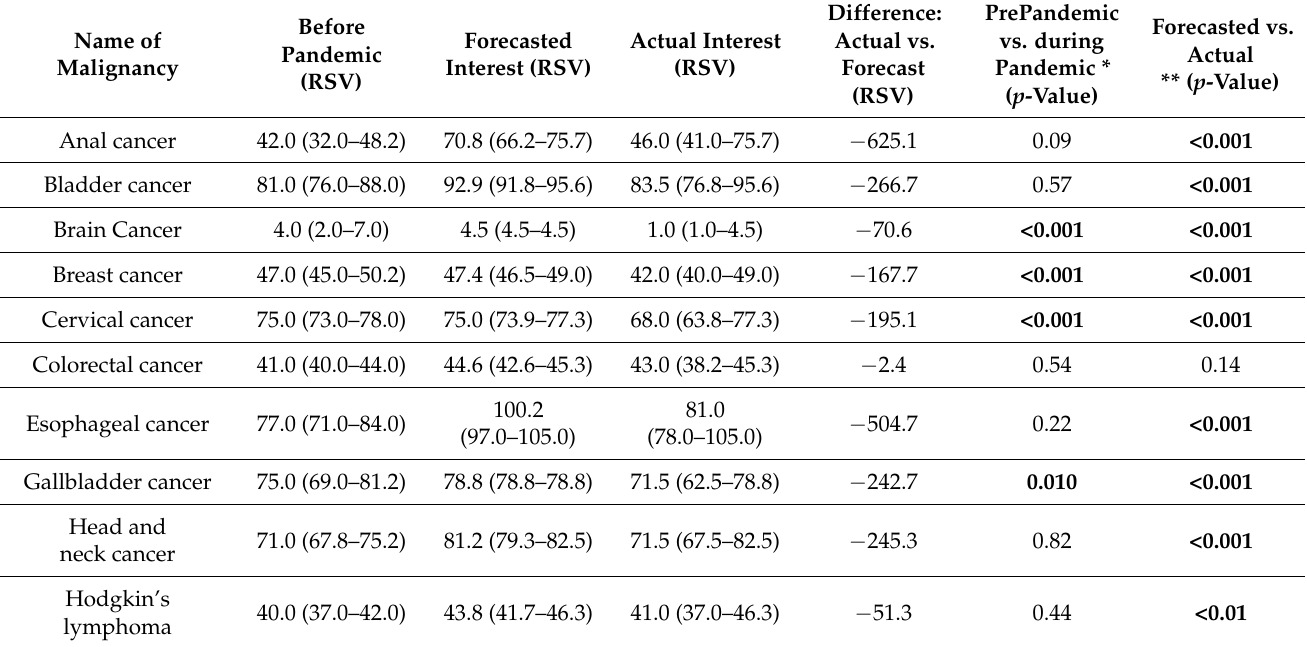
Table 2. Global statistics of Google queries on the chosen